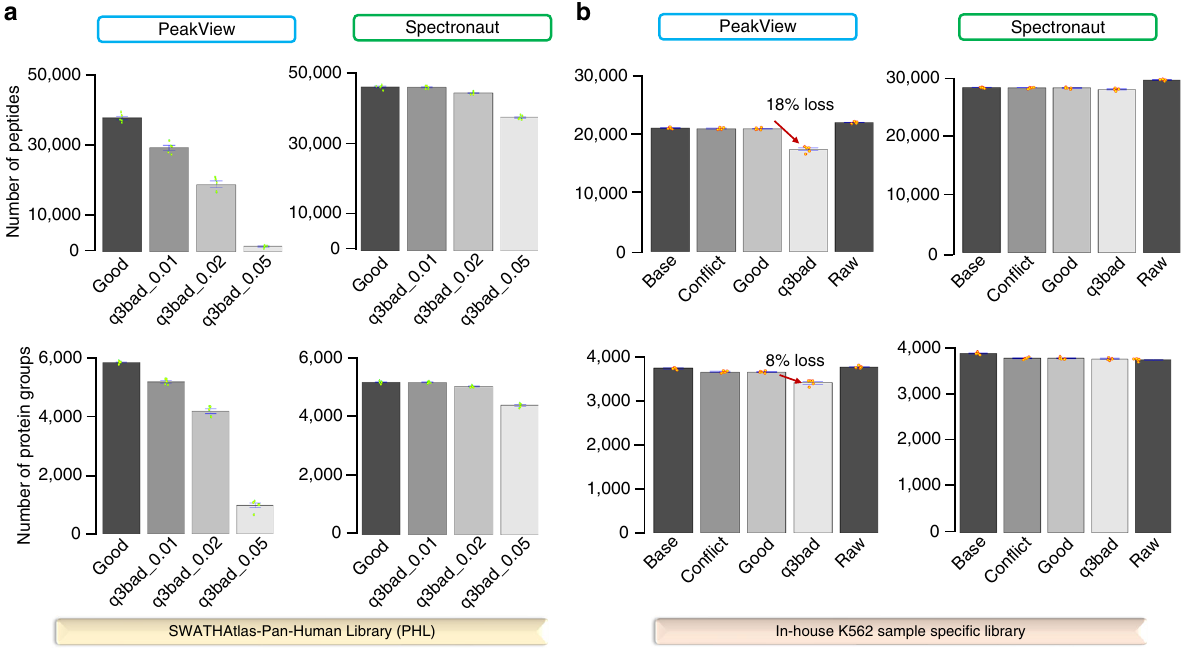
Fig. 2 Comparative performance of spectral libraries analyzed in DIA tools. a SWATHAtlas — pan-human library (PHL). DIALib-QC identi fi es the q3 mass error in different PHL libraries. Despite of the q3 m/z error in the libraries, Spectronaut provides higher sensitivity than PeakView as it implements a MS2 calibration strategy. Both peptide and protein group identi fi cations decrease with increasing q3 mass error with PeakView. b In-house K562 sample-speci fi c library. DIALib-QC evaluates various diagnostic criteria and their effect on the number of identi fi cations is represented with different in-house K562 sample-speci fi c libraries. The bar plots highlight the effects of decoy assays (base library), con fl ict assays (fragment ion within the parent q1 precursor swath bin), fragment ion mass error, and redundant spectra on the SWATH analysis. The number of peptides and proteins identi fi ed at an estimated 1% FDR were similar regardless of the library used (except q3bad) and software used (PeakView or Spectronaut.) The fragment ion mass error in the q3bad library had the greatest effect on the PeakView performance, decreasing peptide, and protein identi fi cations by 18% and 8%, respectively, compared to the good library (marked by red arrows). The error bars indicate the variability within fi ve replicates represented as standard error of the mean. These are calculated as the ratio of standard deviation of the number of quanti fi ed peptides or proteins observed in each gradient replicate to the square-root of the sample size ( n = 5). The small green and orange dots denote the number of identi fi cations in each replicate in the PHL and the in-house K562 sample- speci fi c library, respectively. The bar graphs were generated with data provided in Supplementary Data fi le 4,